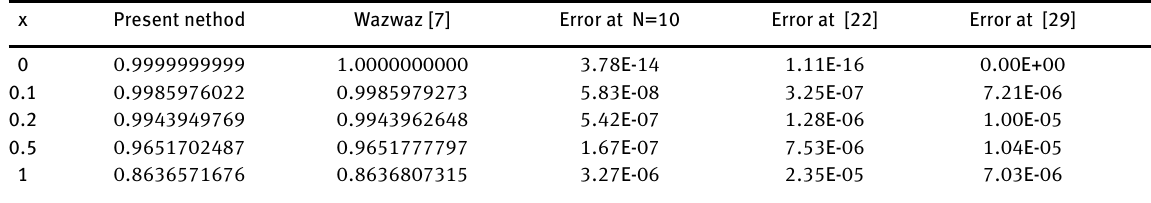
Table 3: Comparison of approximate solutions and error obtained by modified method with series solution wazwaz [7], and newly advanced